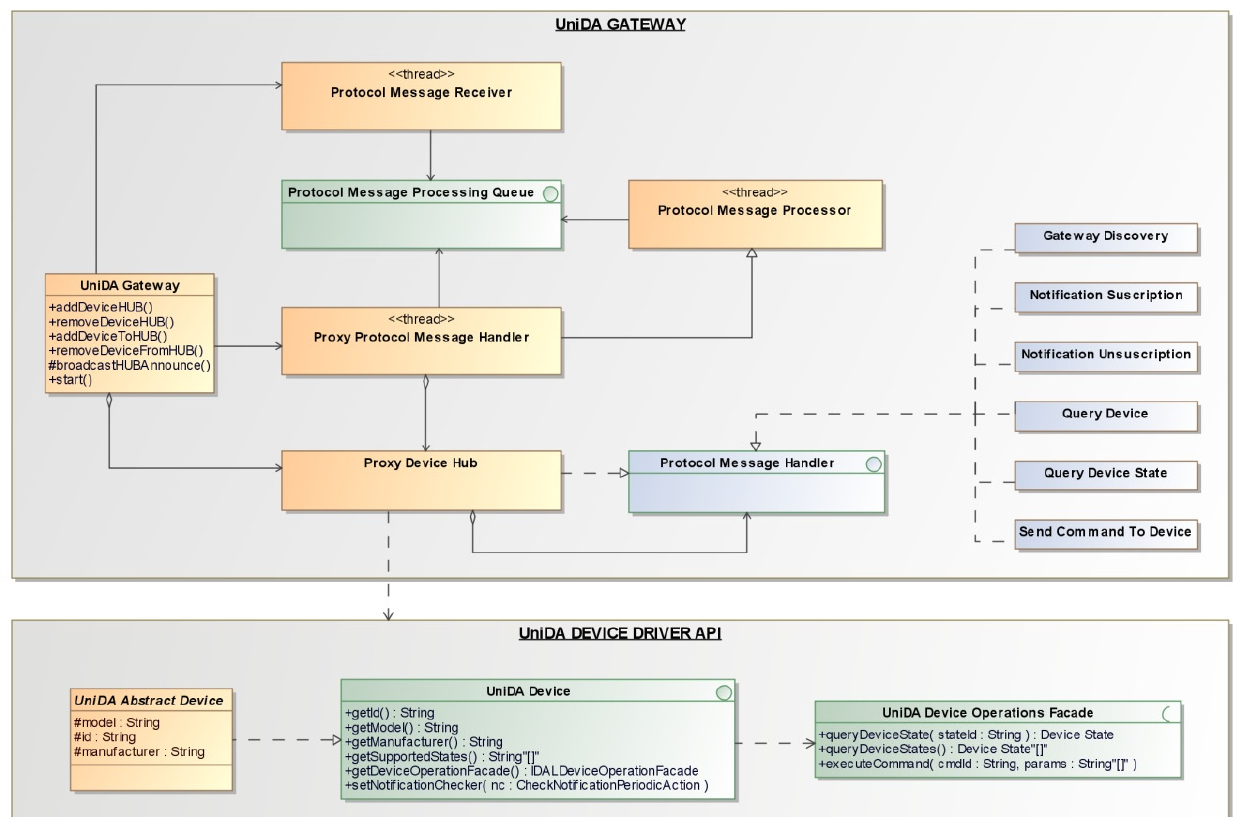
Figure 4. Simplified class diagram of the generic gateway